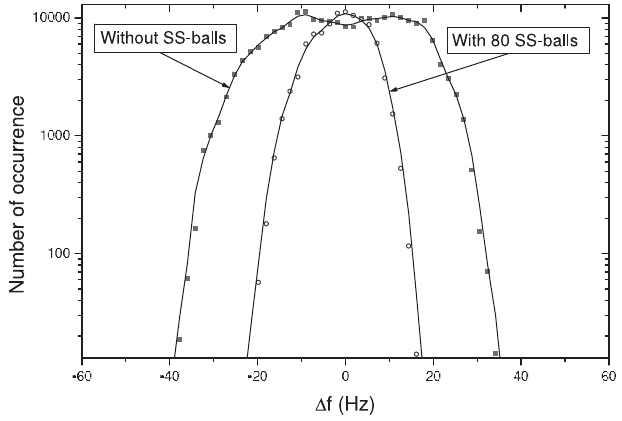
FIG. 7. Frequency excursion ( (cid:1) f ) of a superconducting reso- nator at 4.2 K with and without the vibration